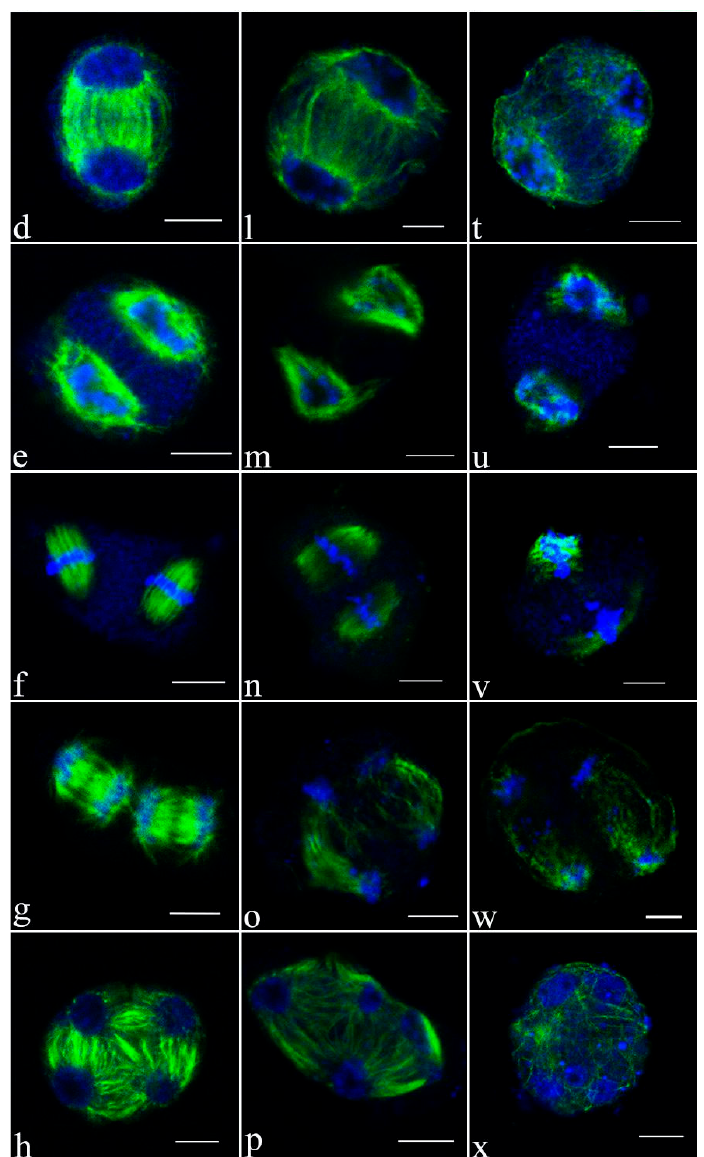
Figure 6. Defects in the meiotic microtubular cytoskeletons of PMCs exposed to 38 ◦ C for 3 h or 6 h in P. canescens . ( a – h ) Meiotic microtubule distributions of PMCs from the control group. ( i – p ) Defects in the meiotic microtubular arrangement of PMCs after treatment at 38 ◦ C for 3 h. ( q – x ) Defects in the meiotic microtubular arrangement of PMCs after treatment at 38 ◦ C for 6 h. ( a , i , q ) Diakinesis. ( b , j , r ) Metaphase I. ( c , k , s ) Anaphase I. ( d , l , t ) Telophase I. ( e , m , u ) Prophase II. ( f , n , v ) Metaphase II. ( g , o , w ) Anaphase II. ( h , p , x ) Telophase II. Tubulin- α is shown in green, and DAPI is shown in blue. Scale bars = 10 µ